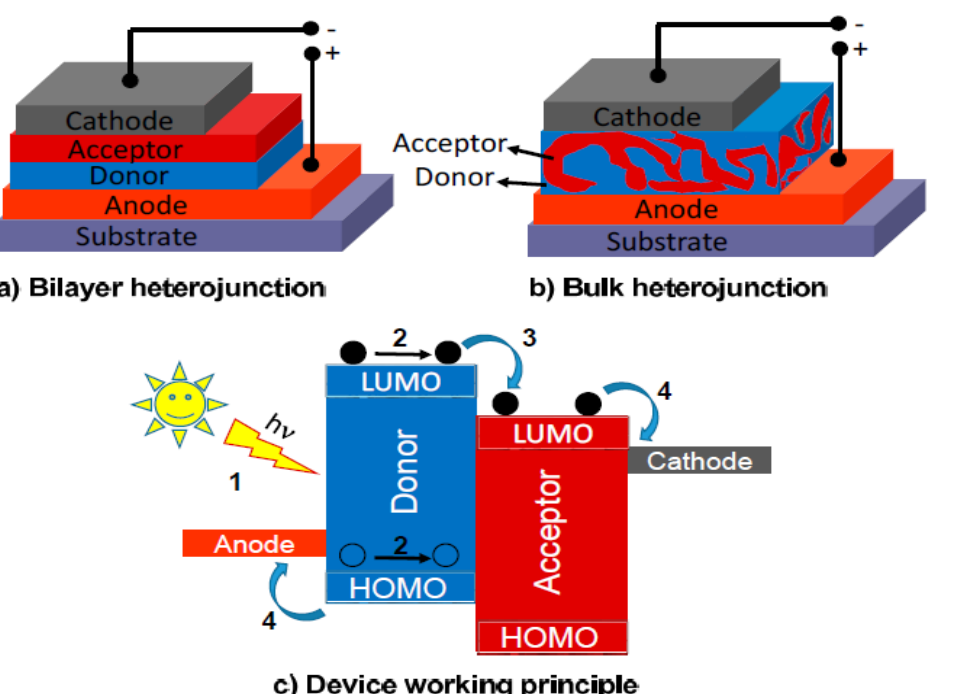
Figure 1. Device structures ( a , b ); and basic photovoltaic effect process ( c ). Reprinted with permission from reference [64].